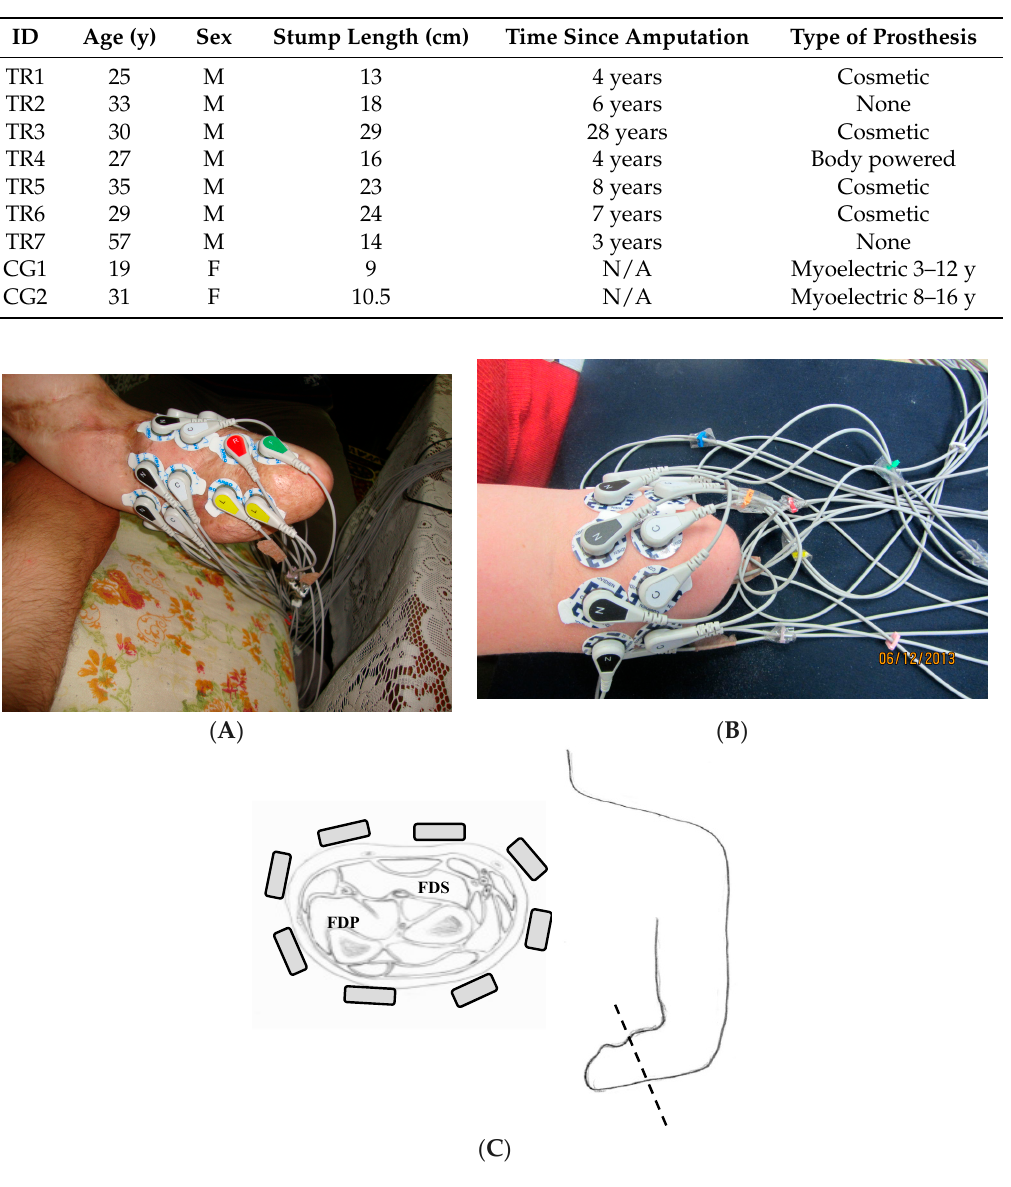
Figure 2. Examples of electrode locations for 2 amputees, ( A ) Transradial amputee TR4, ( B ) Congenital amputee CG2, ( C ) Cross section of the forearm with approximate electrode locations over the muscles: Flexor Digitorum Superficialis (FDS) and Flexor Digitorum Profundus (FDP) for Transradial amputee TR4.